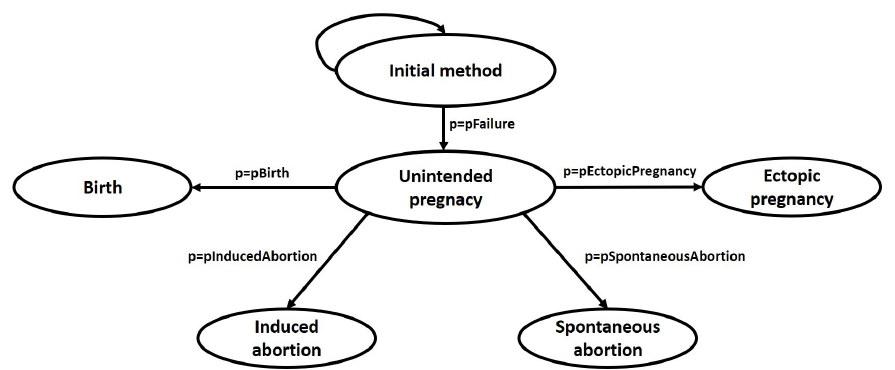
Figure 1. Model schematic. pFailure: transition probability of method failure; pBirth: transition probability of birth; pInducedAbortion: transition probability of induced abortion; pSpontaneousAbortion: transition probability of spontaneous abortion; pEctopicPregnancy: transition probability of ectopic